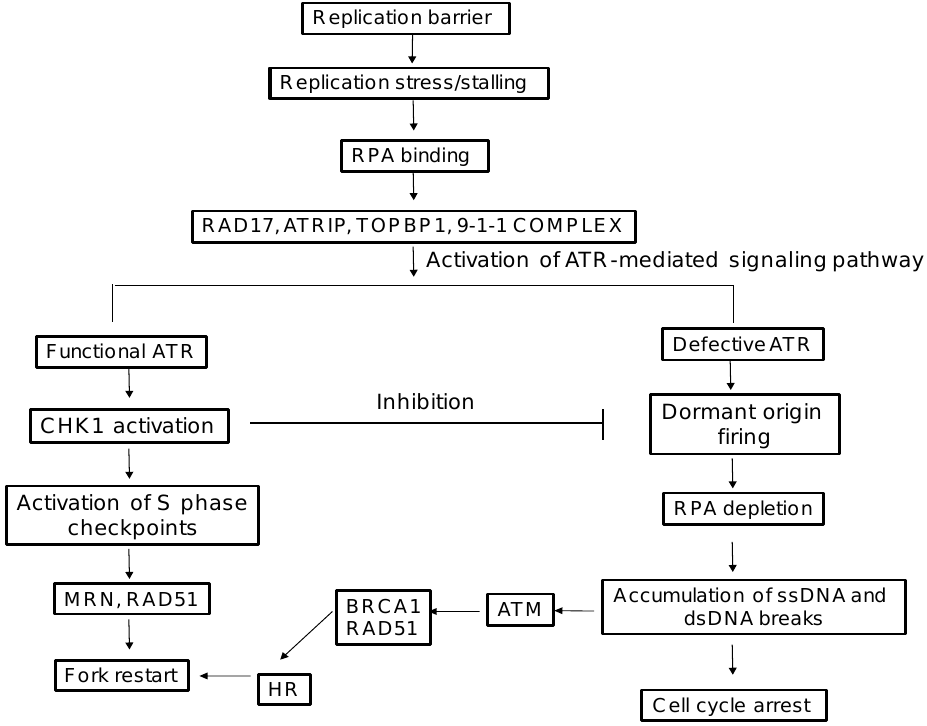
Figure 2. Ataxia telangiectasia and Rad3-related protein/(ataxia-telangiectasia mutated) Figure2. AtaxiatelangiectasiaandRad3-relatedprotein / (ataxia-telangiectasiamutated)serine / threonine serine/threonine kinase (ATR/ATM)-activated pathways for resolving stalled replication forks. kinase (ATR / ATM)-activated pathways for resolving stalled replication